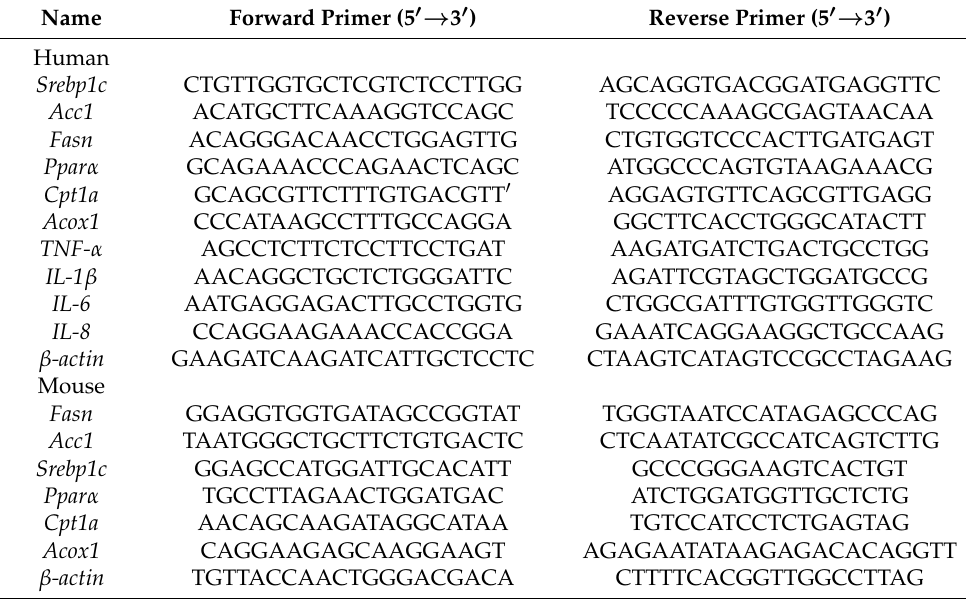
Table 1. Sequences for real-time PCR